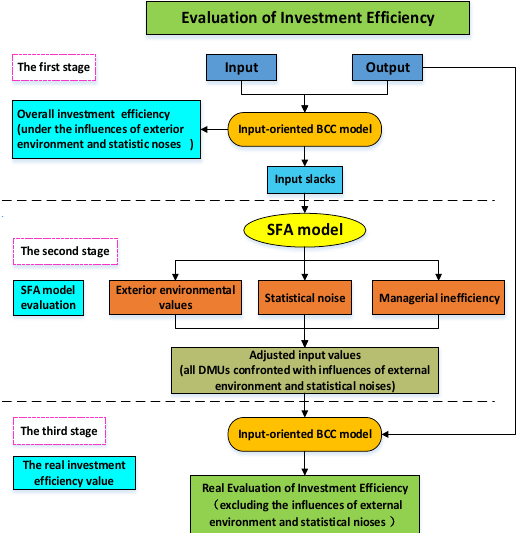
Figure 1. Research methods for investment efficiency of power grid enterprises (PGEs). SFA: stochastic frontier analysis.